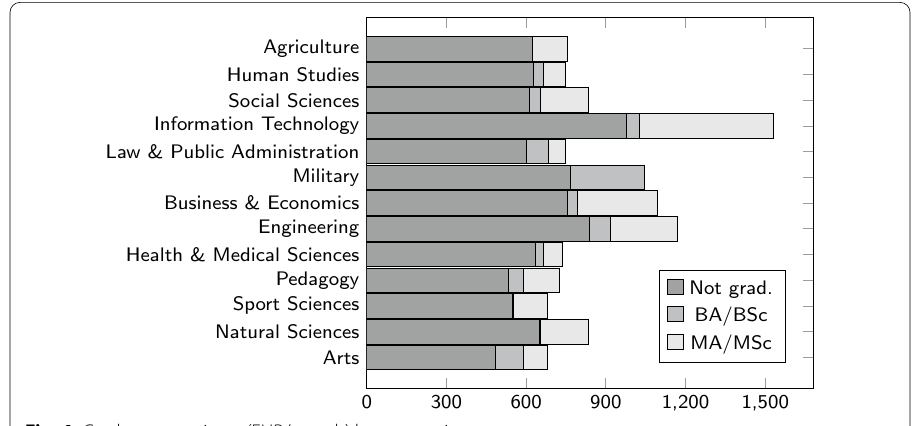
Fig. 4 Graduate premiums (EUR/month) by occupation category